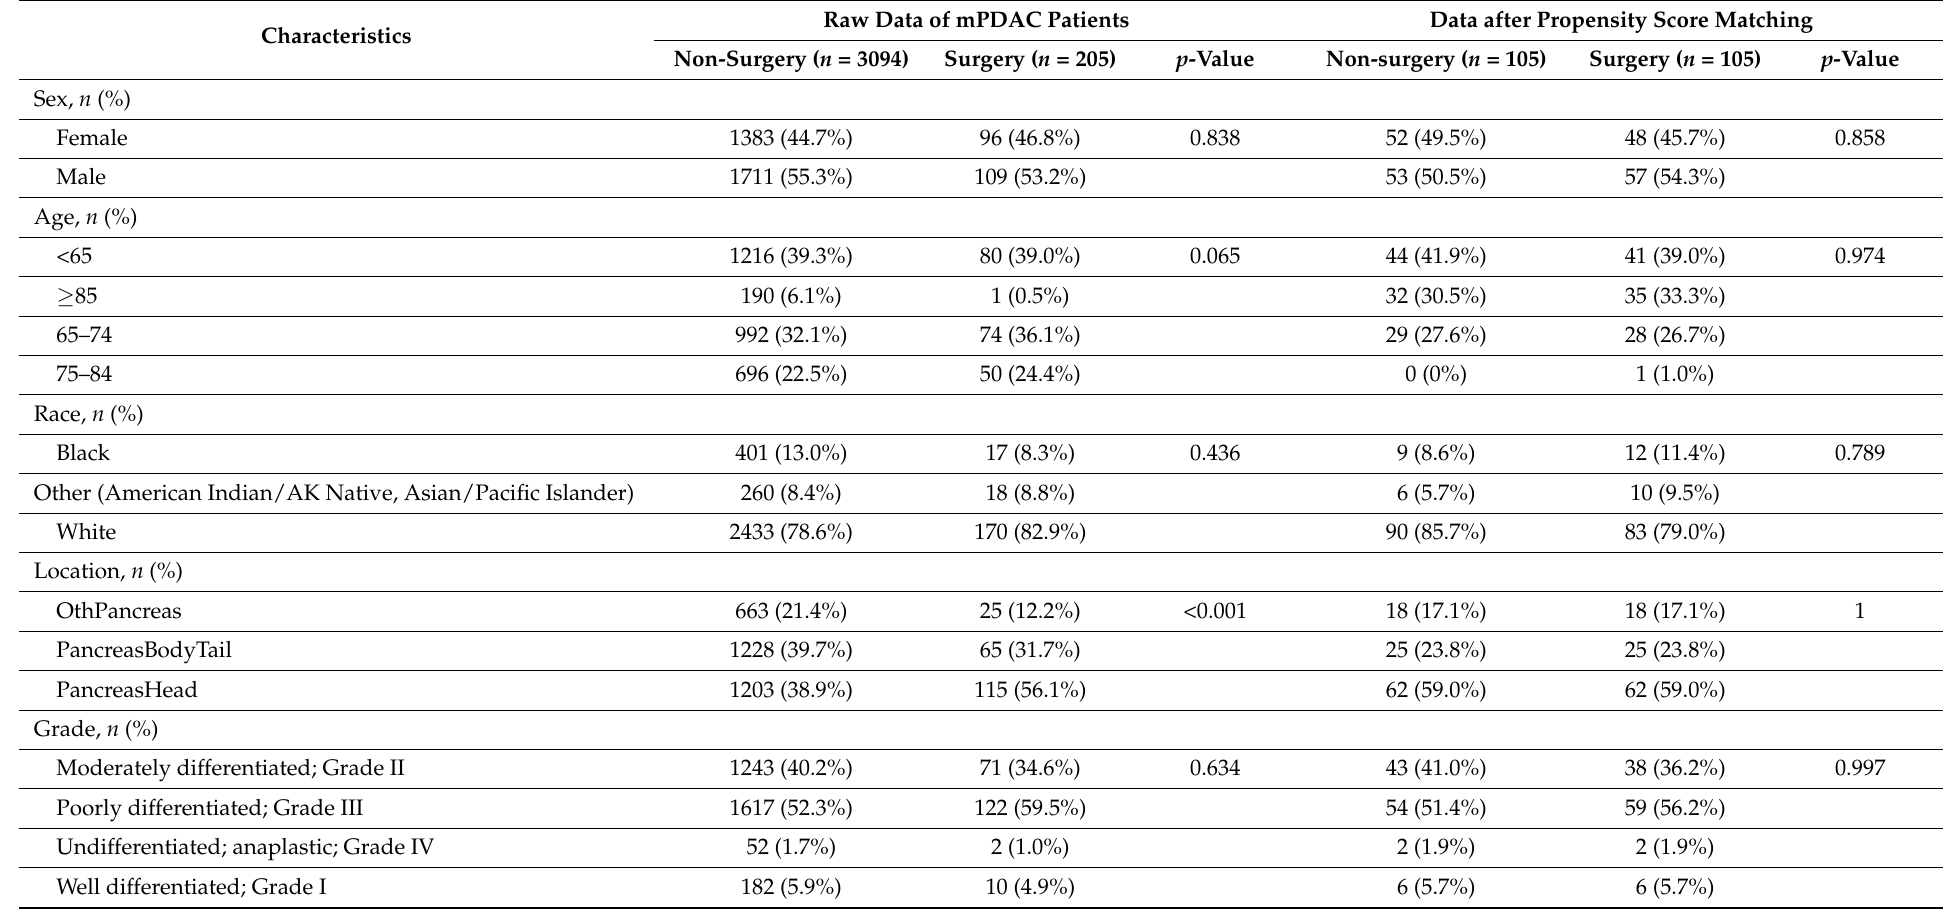
Table 1. Baseline characteristics of mPDAC patients before and after propensity score